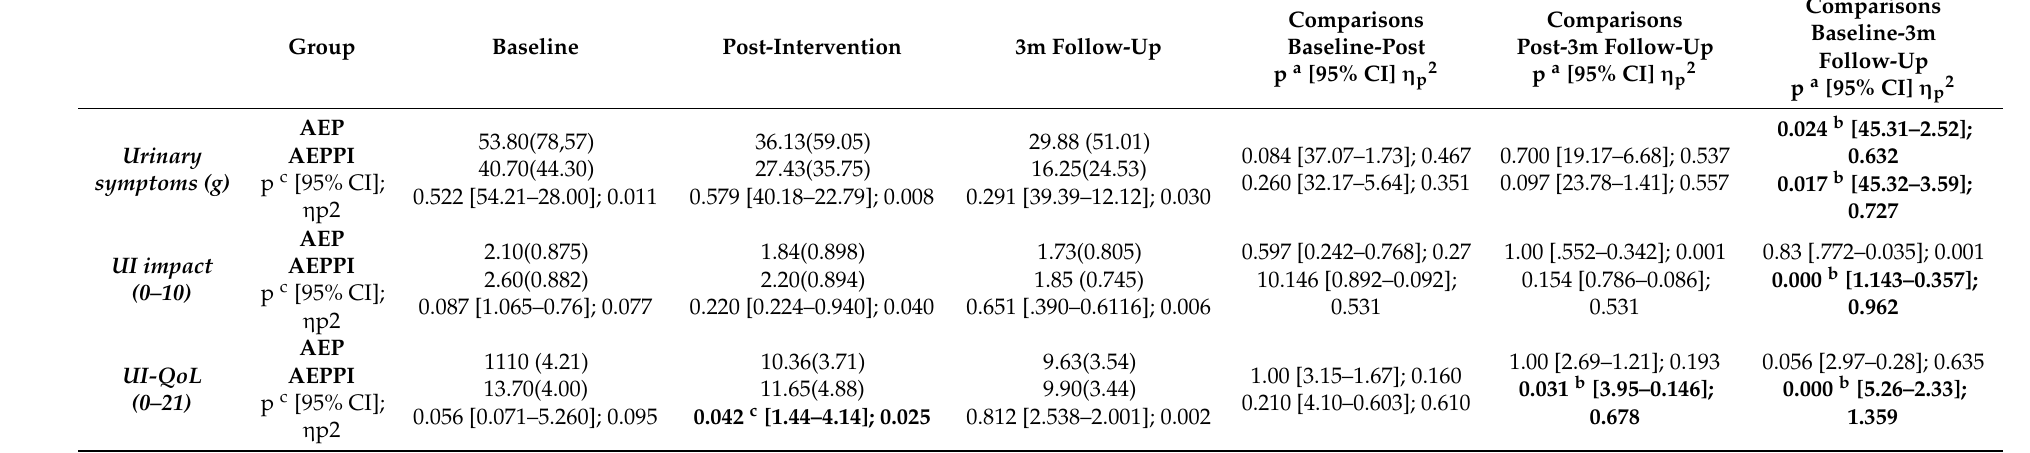
Table 2. Results of the comparison for the different variables